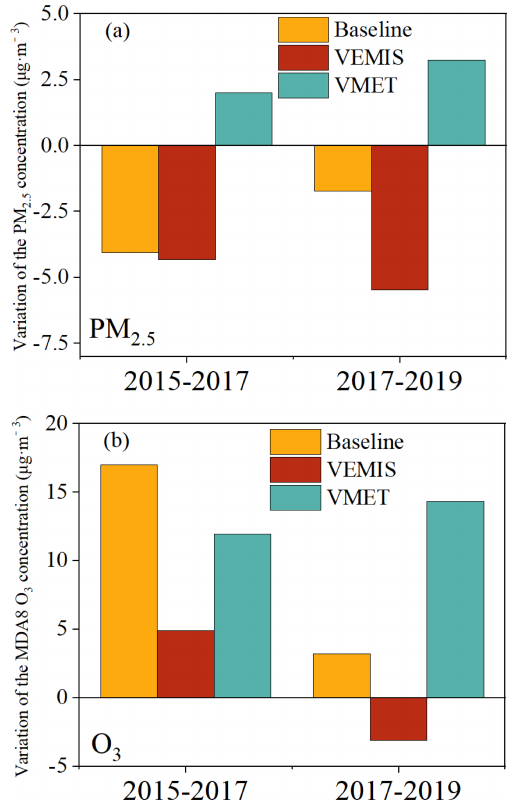
Figure 11. The concentration changes during 2015–2017 and 2017–2019 from CMAQ for (a) PM 2 . 5 and (b) O 3 (VEMIS and VMET: meteorological conditions and emissions fixed at 2017 level,